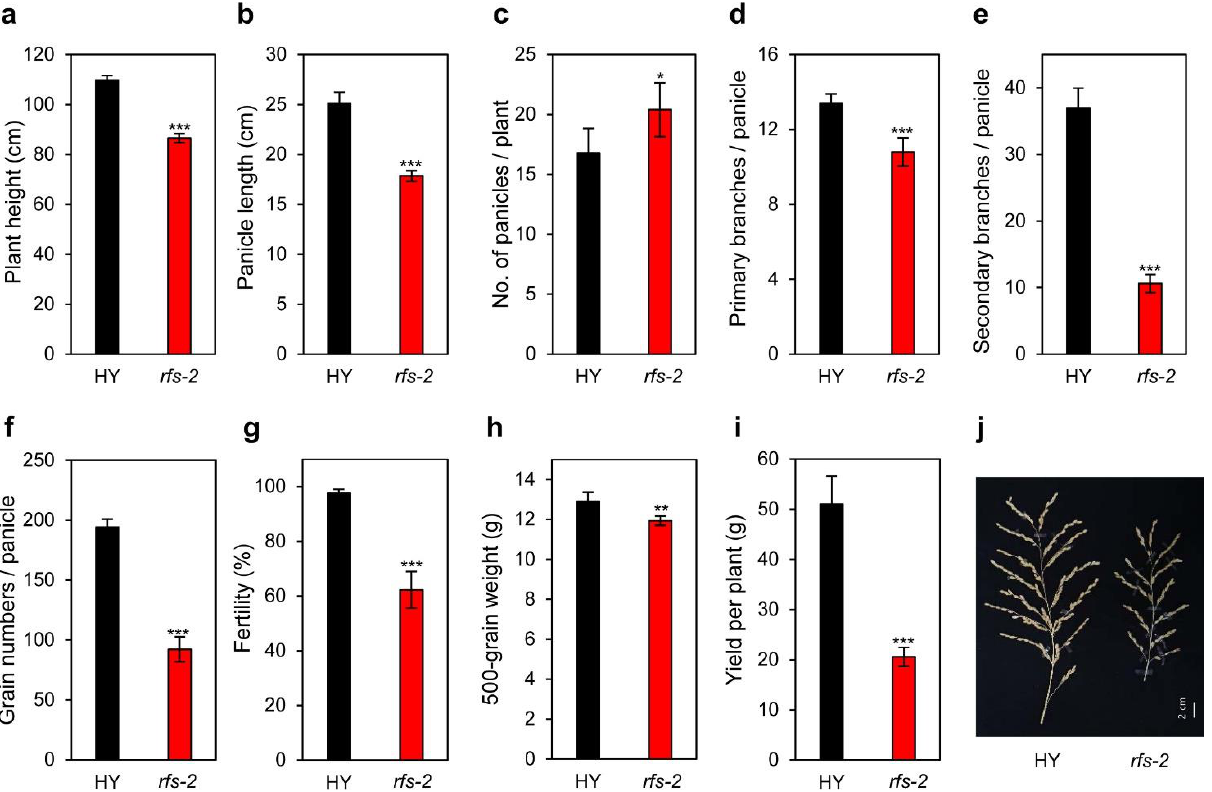
Figure 6. Agronomic traits assessed in the rfs-2 mutant. Nine agronomic traits were examined and compared in the HY and rfs-2 plants after harvest in the autumn. Plant height ( a ), panicle length ( b ), number of panicles per plant ( c ), number of primary branches per panicle ( d ), number of secondary branches per panicle ( e ), number of grains per panicle ( f ), spikelet fertility ( g ), 500-grain weight ( h ), yield per plant ( i ), and phenotype of panicles ( j ). Values are shown as means ( n = 5) and error bars indicate standard deviation. Differences between means were compared using two-tailed Student’s t -tests (* p < 0.05, ** p < 0.01, *** p < 0.001).